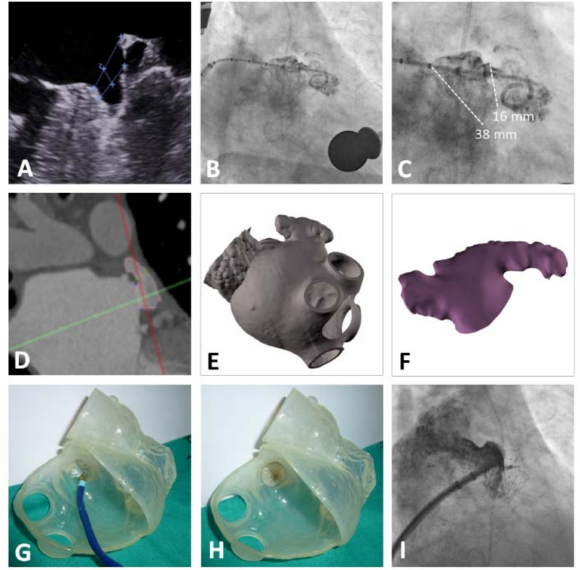
Figure 2. Small, slight, and multilobar LAAC. Legend: ( A ) TEE image of the LAA. ( B , C ) LAA angiography. ( D ) CT of the LAA. ( E , F ) Three-dimensional reconstruction of the LAA. ( G , H ) 3D- printed model to help with selection of the device size and plan the procedure. ( I ) Successful implantation of a 16-mm LAmbre™